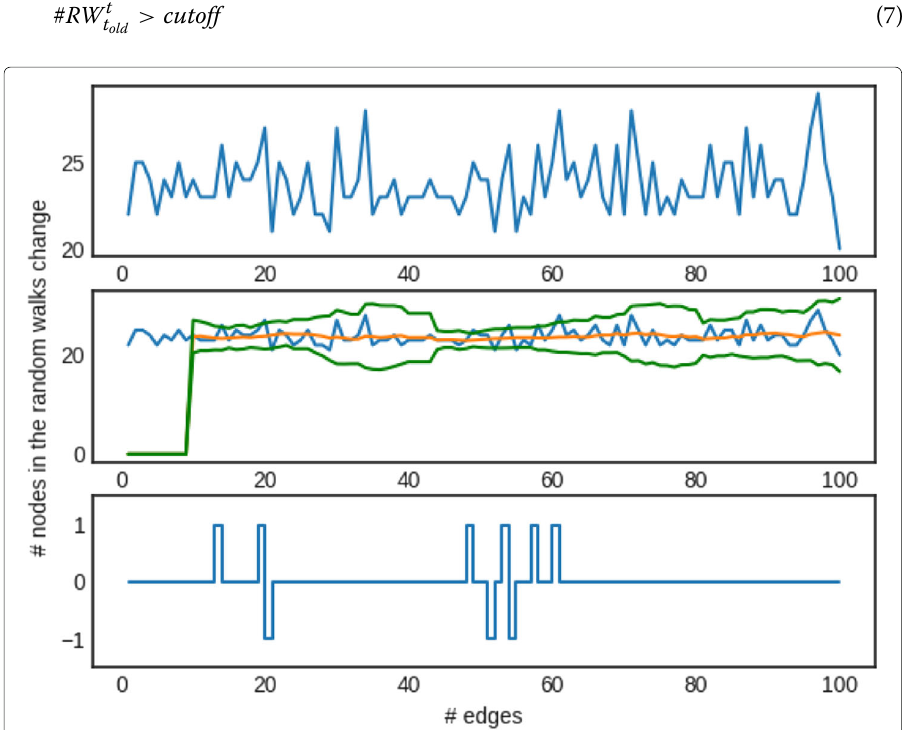
Fig. 4 Example peak detection method for the case of adding edges in the BlogCatalog network. The upper plot shows the number of random walks that are updated in RW as a function of new edges added. It is evident that some edges have a larger effect in RW as depicted by higher values. The middle plot, shows the mean (middle almost straight line), as well as the boundaries defined by the current threshold of τ × std (the two lines above and below the mean line). The bottom plot provides the signal for decision making; every time that the current change at time t is outside the threshold it signals that a network embedding should be obtained. In the example this is the case for five times t = { 13,19,48,53,57,60